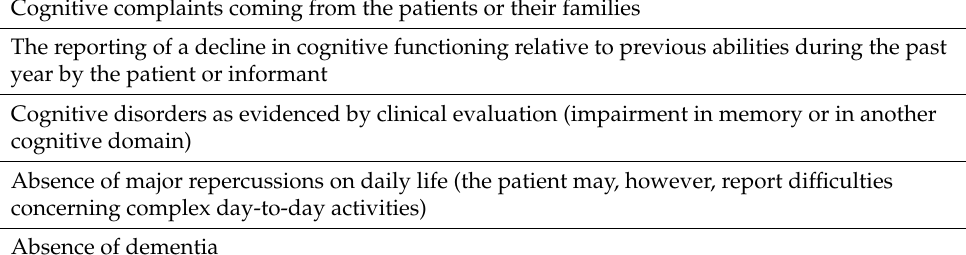
Table 10. Criteria for the identification of MCI, according to the MCI Working Group of the European Consortium on Alzheimer’s Disease, Brescia Meeting, Italy, June 2005 [28]. Cognitive complaints coming from the patients or their